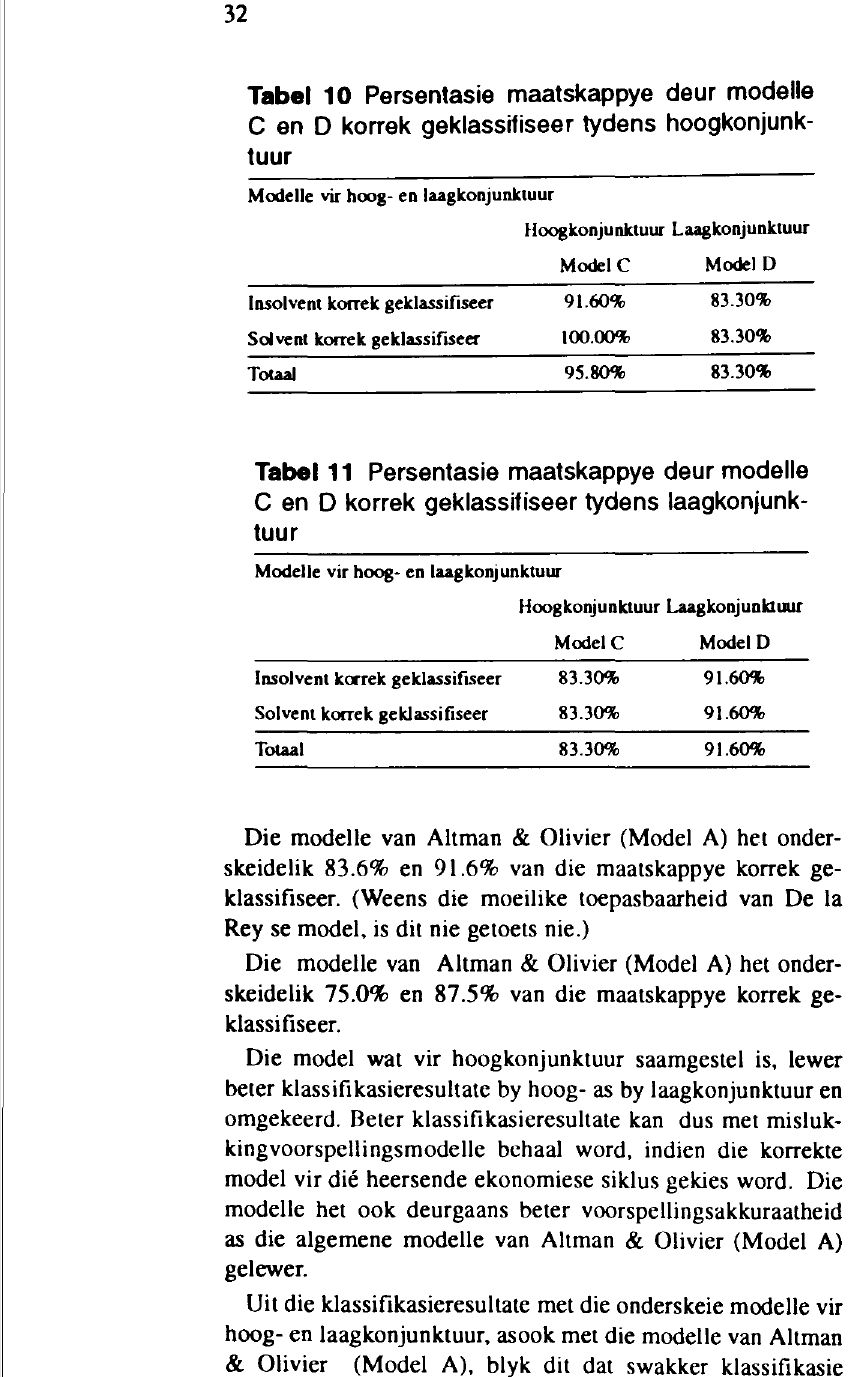
Tabel 1 O Persentasie maatskappye deur modelle